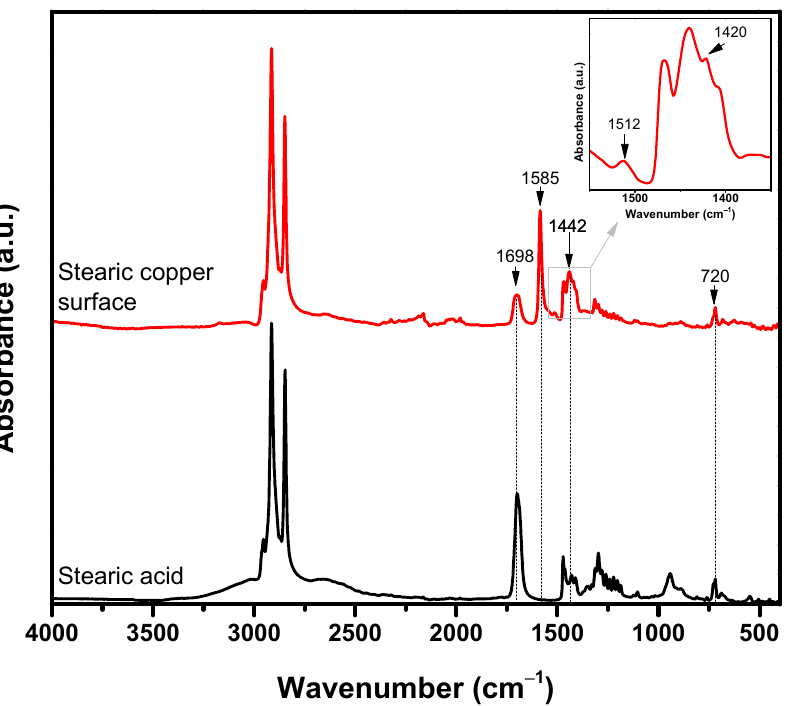
Figure 3. ATR-FTIR spectra of stearic acid and stearic copper surface after modification. The inset presents the region of interest regarding the presence of silver stearate in the spectrum of stearic copper surface.